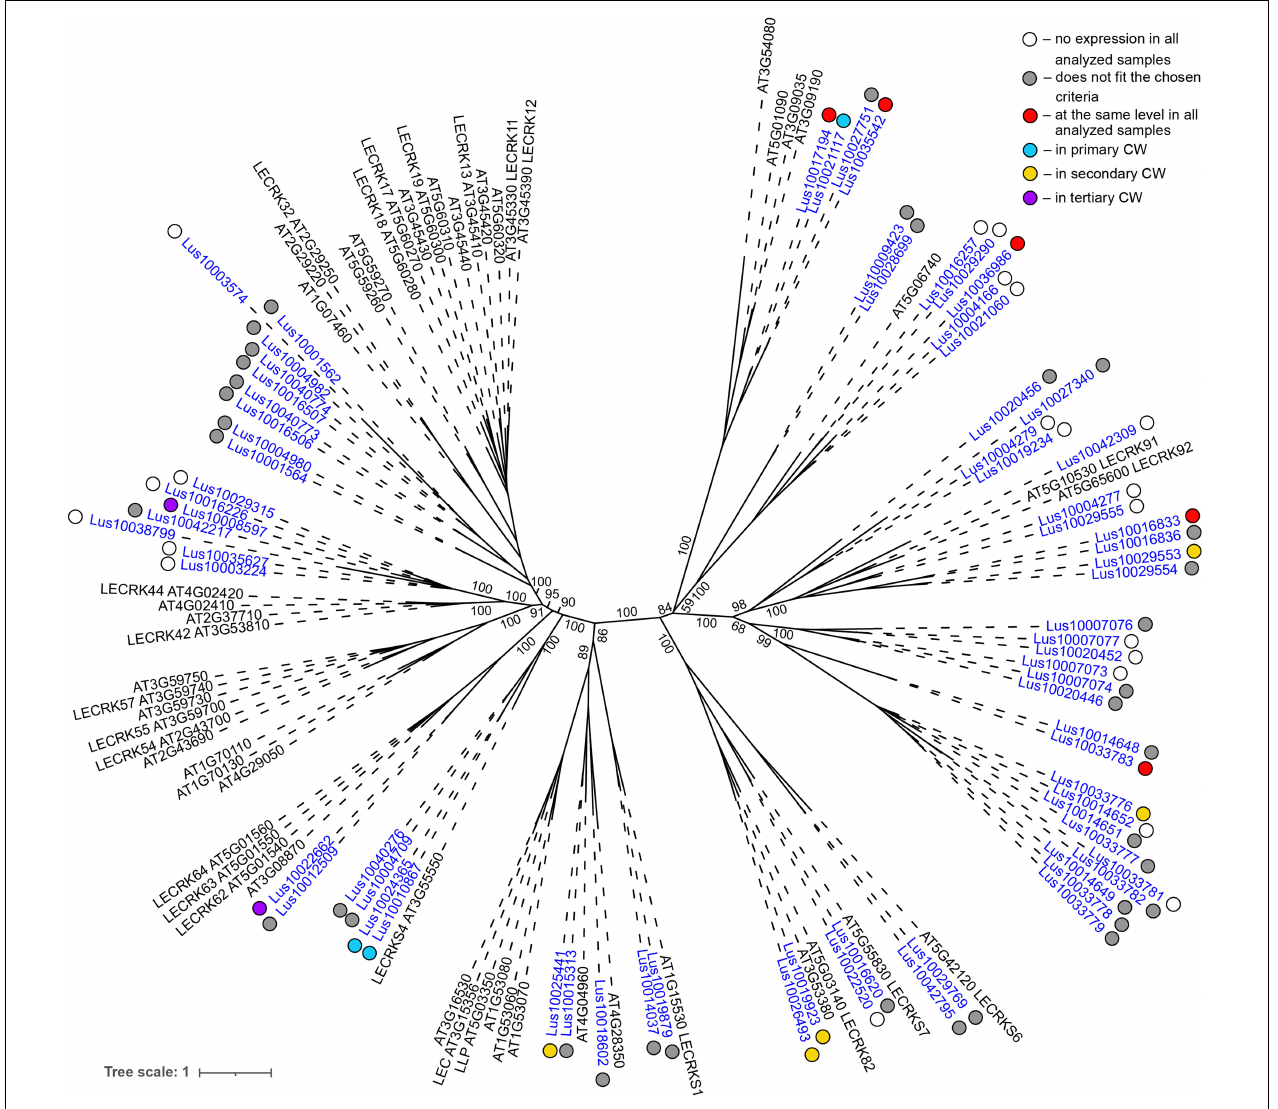
FIGURE 4 | Phylogenetic dendrogram of legume (PF00139) lectin family members of Arabidopsis thaliana and Linum usitatissimum . The A. thaliana gene names are given in black font; additional gene names are given according to descriptions in the Uniprot database (https://www.uniprot.org/; The UniProt Consortium, 2019). The L. usitatissimum gene names are given in dark blue font. The different colored dots next to L. usitatissimum gene names indicate genes with different expression patterns. The criteria used for different expression pattern identification as follow: red, the mean values of tau-score < 0.15 across all samples; light blue, DEGs upregulated in samples with primary CW; yellow, DEGs upregulated in samples with secondary CW; purple dots, DEGs upregulated in samples with tertiary CW. Flax genes with red, light blue, yellow, and purple dots are listed in Tables 2–5 , respectively. White dots indicate genes that are not expressed in the analyzed flax samples, and gray dots indicate genes where the expression does not fit the chosen criteria for a certain expression pattern (expression values for these genes are given in Supplementary File 3 ). Numbers indicate the ultrafast bootstrap support values for some branches. Abbreviations: DEGs, differentially expressed genes, a pairwise comparison log 2 FC ≥ 1; padj ≥ 0.01, CW, cell